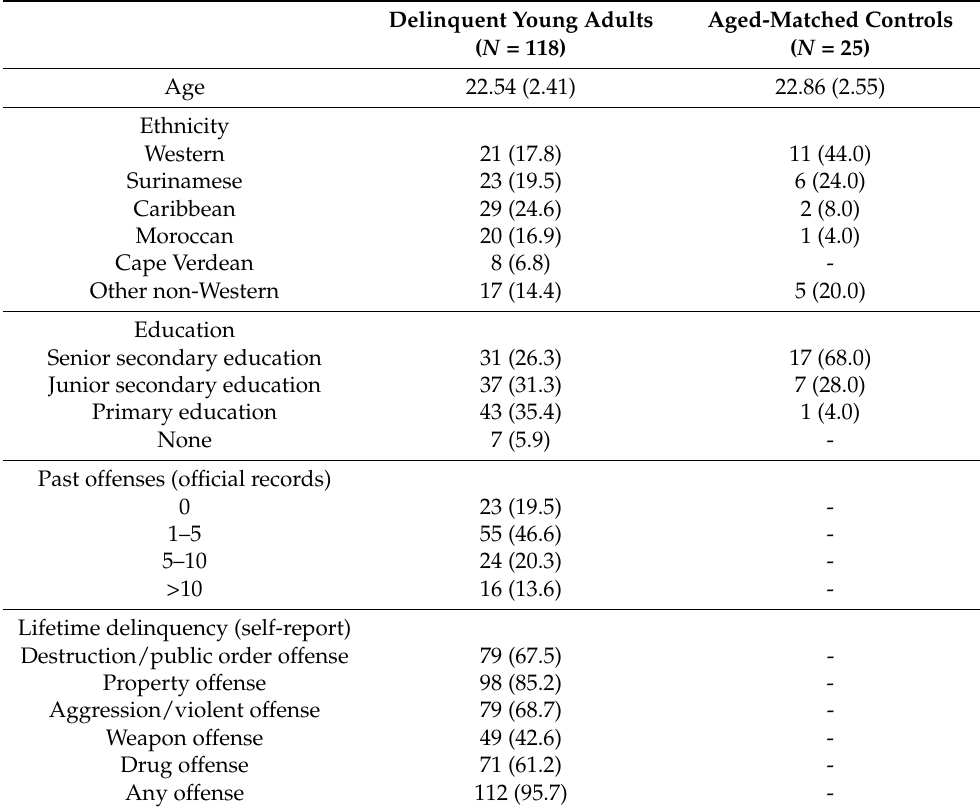
Table 1. Demographic variables for delinquent young adults and controls ( N =